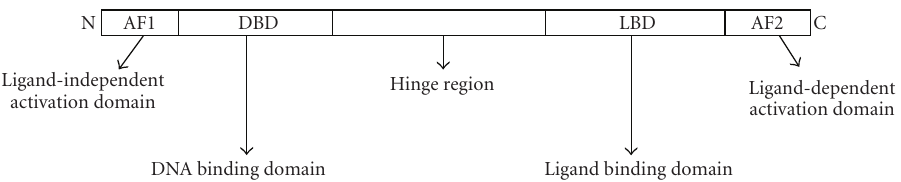
Figure 1: Domain structure of PPARs. PPARs contain the following functional regions: a N-terminal domain with AF-1 domain (ligand- independent activation domain), a DNA binding domain (DBD) with two zinc fingers, a hinge region, and a C-terminal ligand binding domain (LBD) and AF-2 domain (ligand-dependent activation domain).